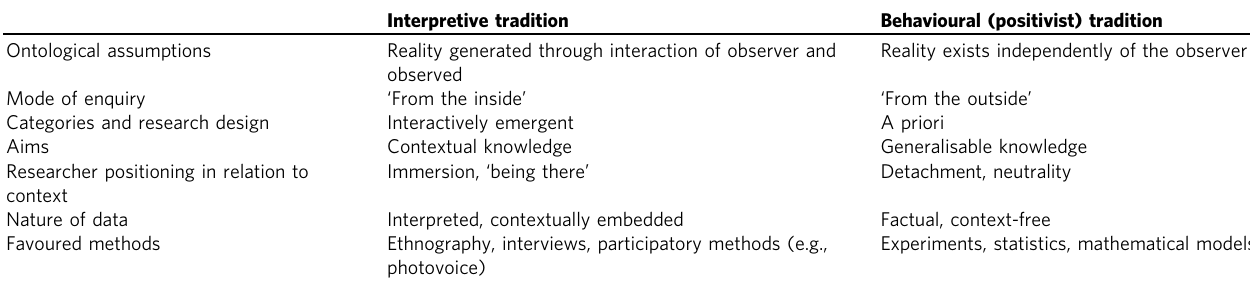
Table 1 The ‘ stereotypical view ’ of differences between interpretive and behavioural (positivist) methodological approaches. Adapted from Evered and Reis Louis